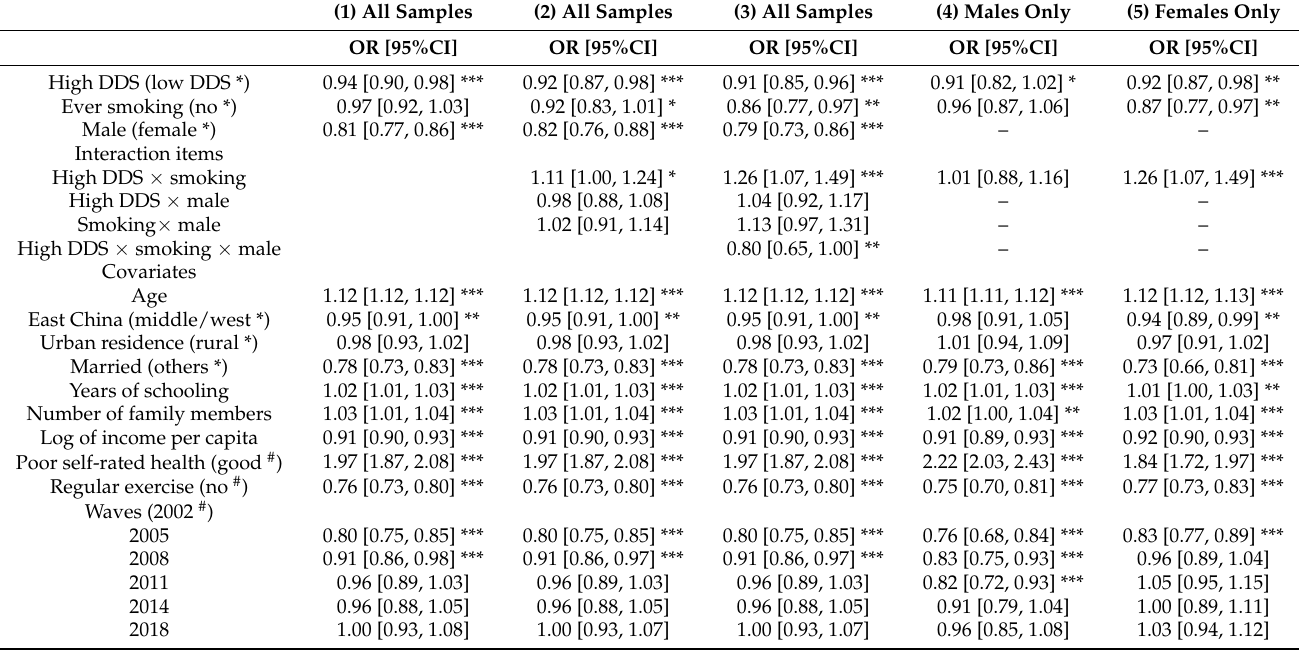
Table 3. “DDS–smoking–gender” three-way interaction effects on cognitive impairment of older adults from GEE logit regression models of six waves of the CLHLS (2002–2018) with DDS as a dichotomous